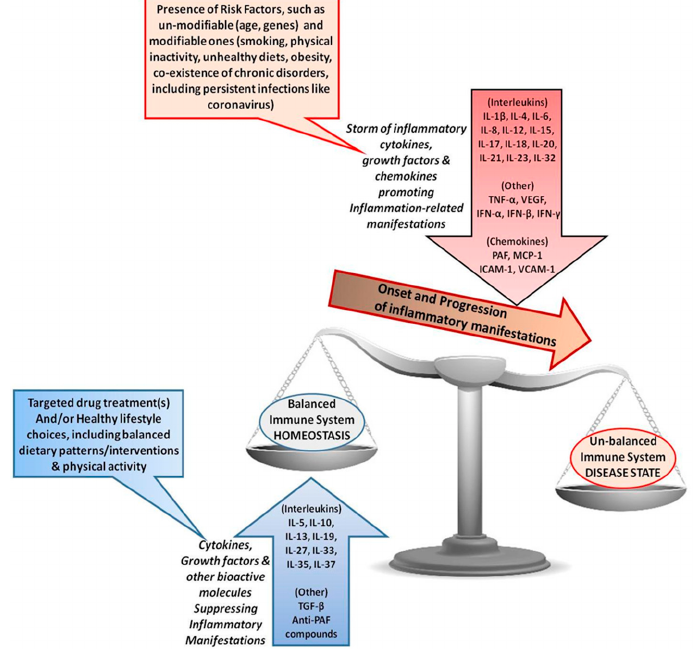
Figure 3. A representation of the inflammatory molecules involved in infection and how certain dietary components may interact with them. Included are the cytokines, growth factors, and other of the immune system, and a diseased state due to the effects of several unmodifiable and modifiable risk factors. Targeted drug treatments and/or healthy lifestyle choices such as balanced diets and physical activity can counterbalance such inflammatory manifestations towards homeostasis.